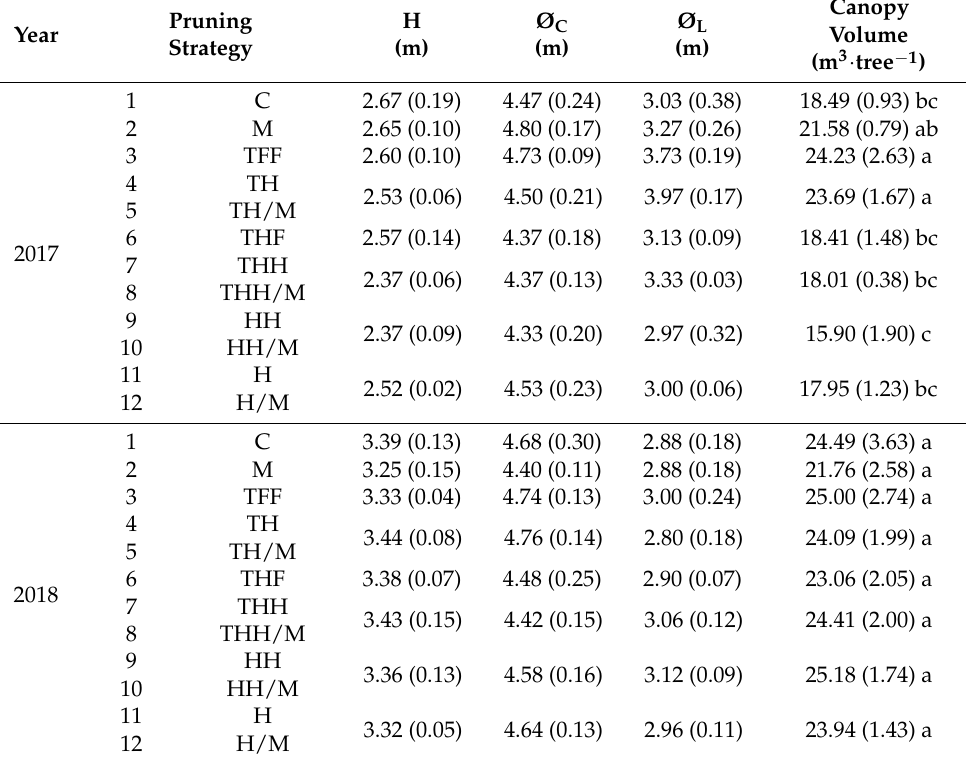
Table 4. Characterization of the canopy size before pruning for each pruning strategy and year. Data are expressed as averages, with standard errors in parentheses. H = canopy height; Ø C = canopy across-row diameter; Ø L = canopy along-row diameter. Different letters between pruning strategies for canopy volume for each year indicate significant differences 1 according to Fisher’s LSD test with 95% confidence intervals. Pruning